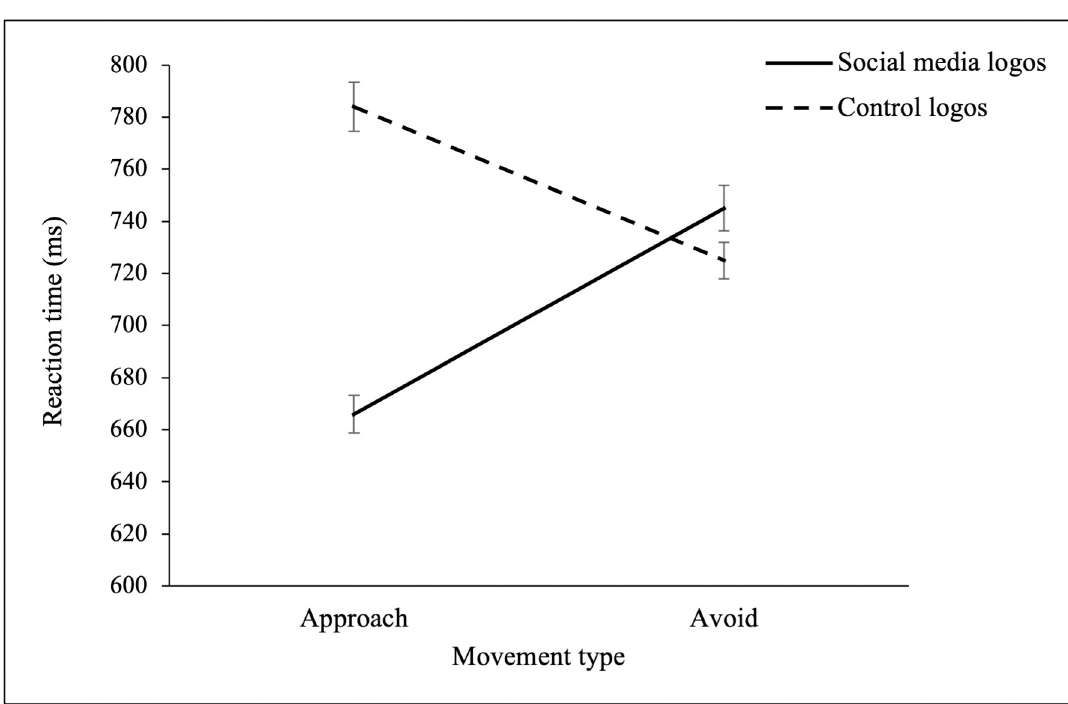
Fig 2. Mean approach and avoidance RTs (ms) to social media and control logos. Error bars represent mean